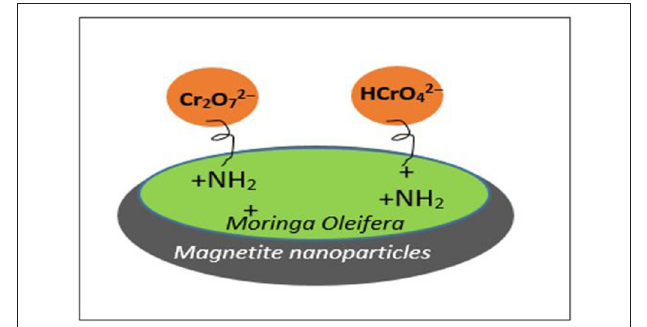
FIGURE 9 | The mechanism for Cr(VI) adsorption by Fe 3 O 4 /FMO.